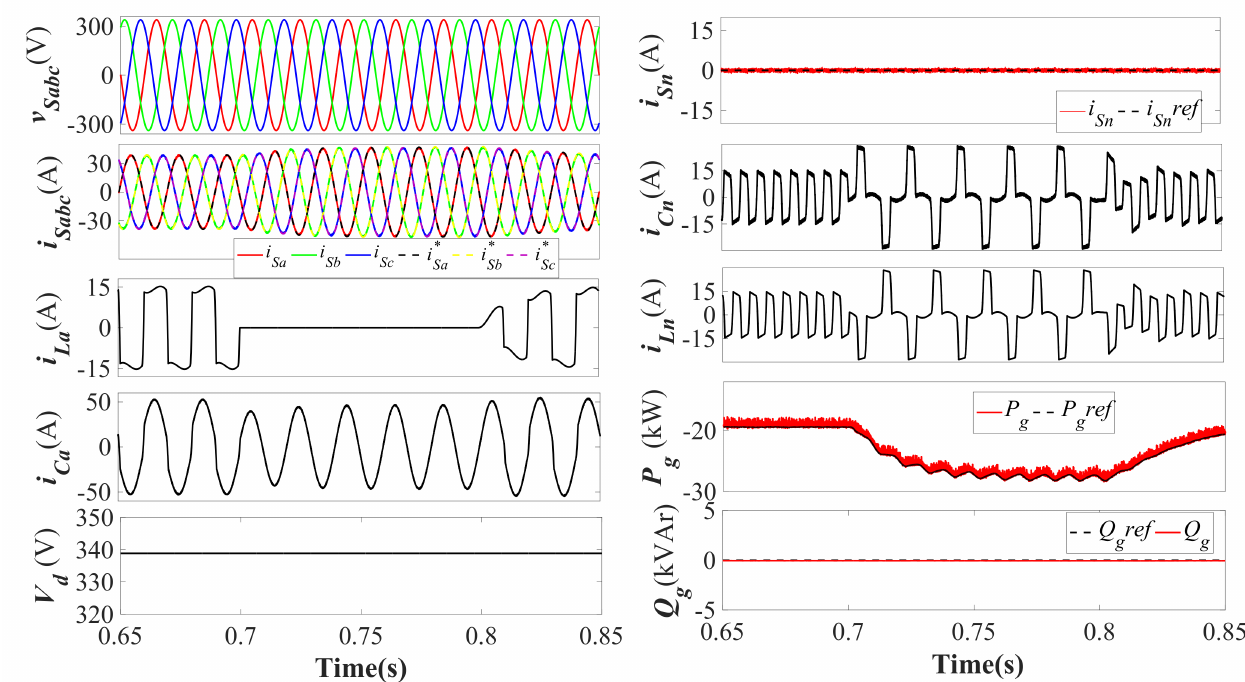
Figure 8. Dynamic performance during load unbalancing of v sabc , i sabc , i Ca , V d , i La , i Sn , i Cn , i Ln , P g , and Q g